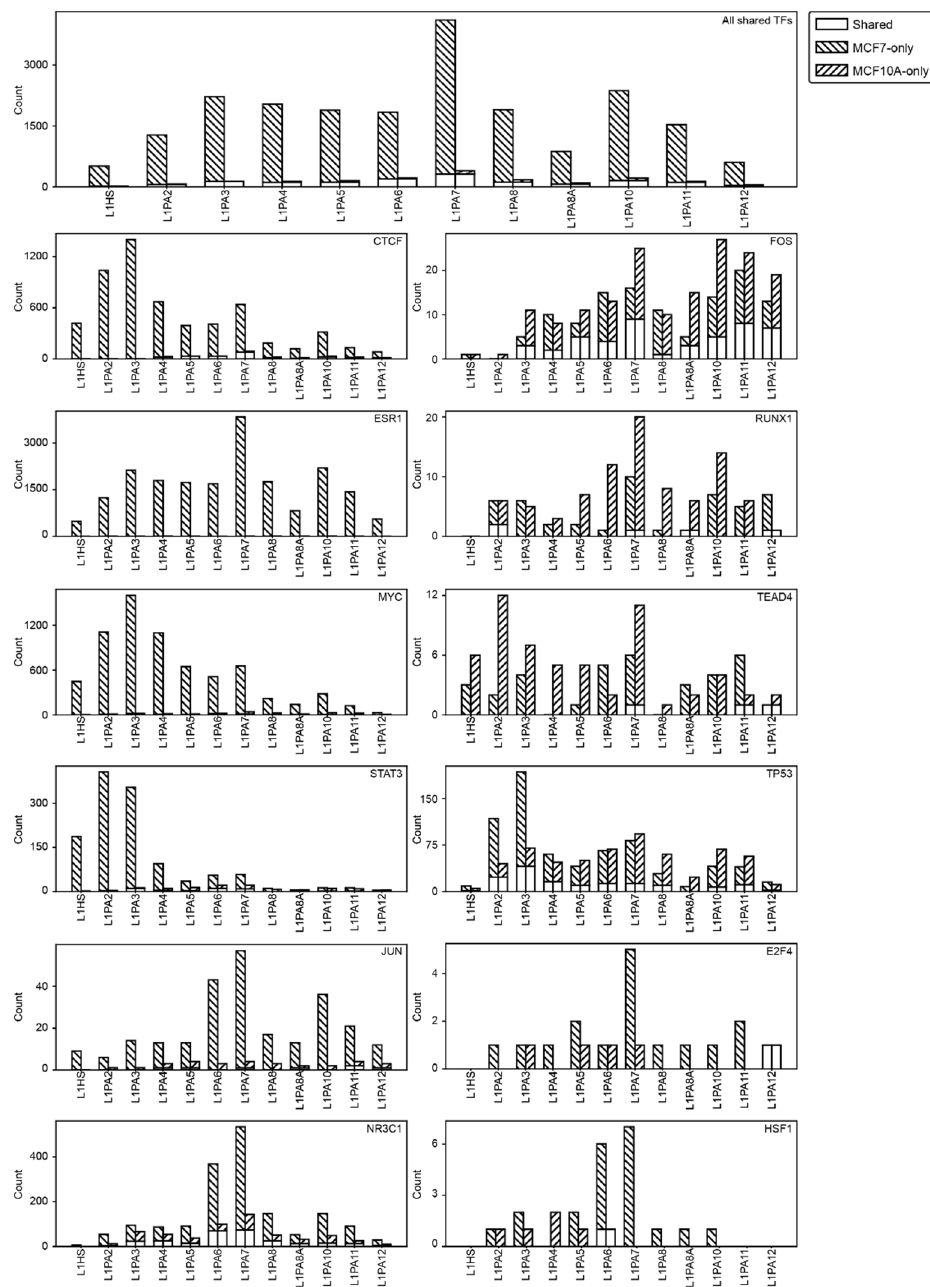
Figure 7. L1 transposons showed a consistent pattern of TF binding activities. Stacked bar graphs represent the number of L1 transposons contributed TFBSs in both MCF7 and MCF10A cells (empty bars), MCF7 cells only (downward stripes) and MCF10A cells only (upward stripes) are shown. The number of L1 transposons with TF binding activity are shown for all 12 TFs studied in both cell lines (top panel) and each individual TF (bottom panels).